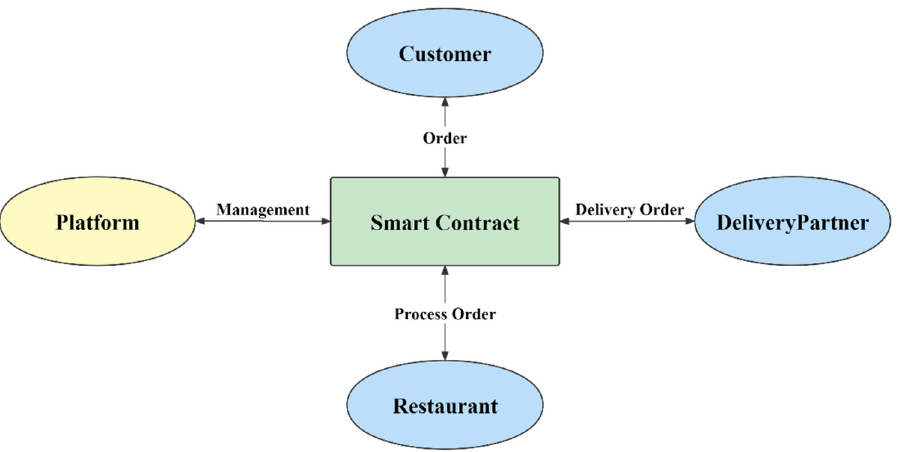
Figure 10. Smart contract participation model in food delivery platform.